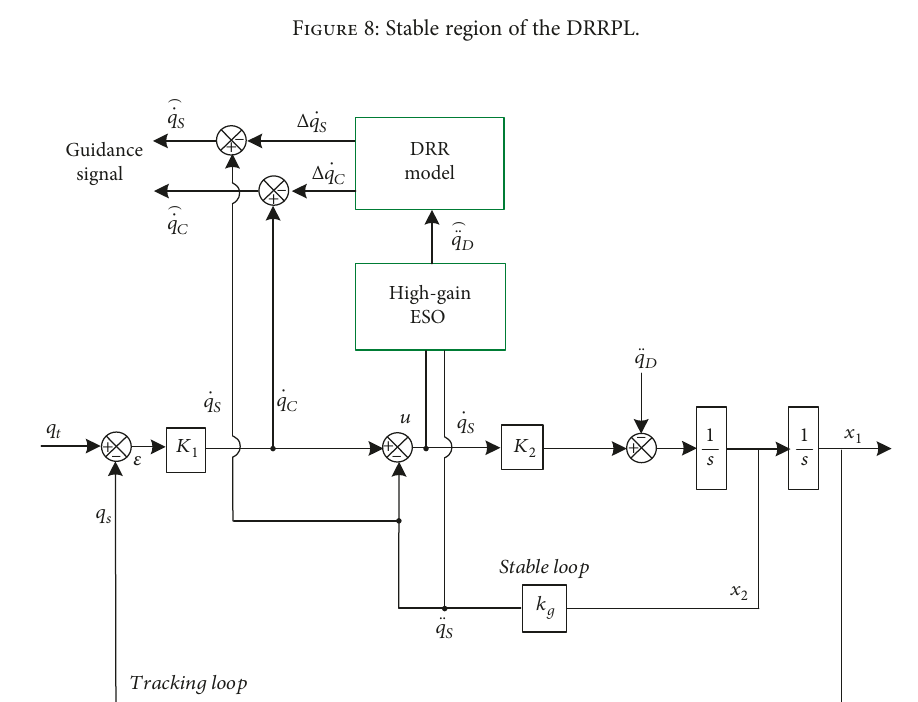
Figure 9: Compensation scheme of